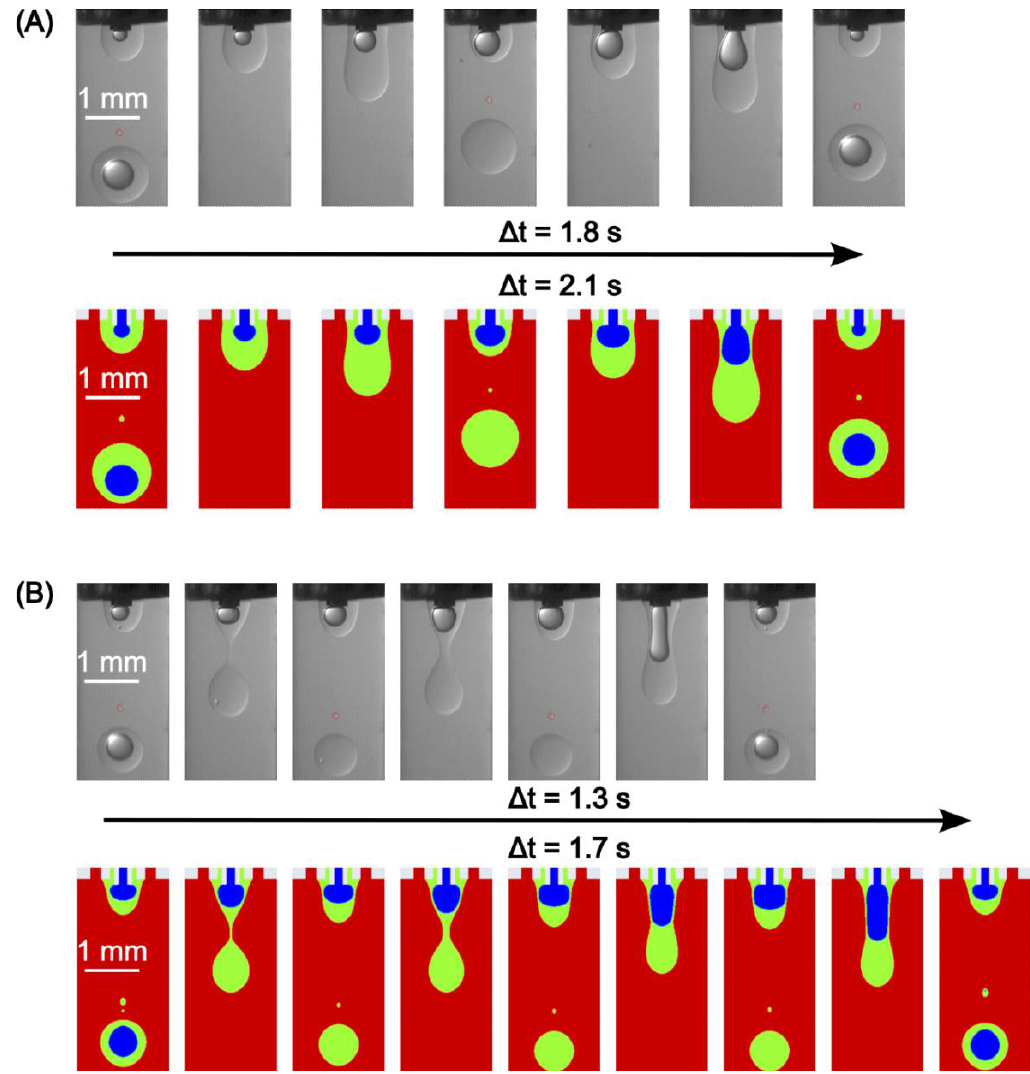
Figure 5. Droplet formation with mismatch at Q 1 = 3 µL/min, Q 2 = 30 µL/min and: ( A ) Q 3 = 500 µL/min; ( B ) Q 3 = 1000 µL/min.